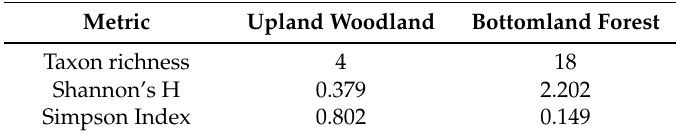
Table 6. Diversity metrics for Presettlement Upland Woodland and Bottomland